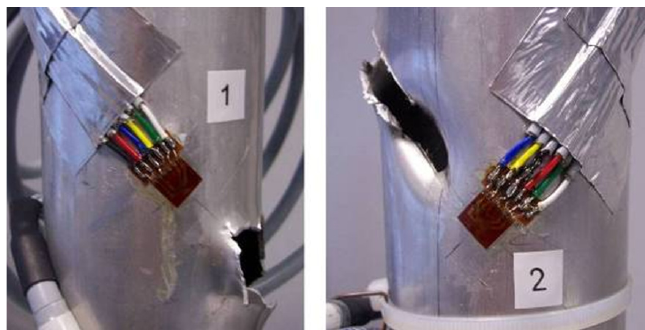
Figura 18: Posizione delle